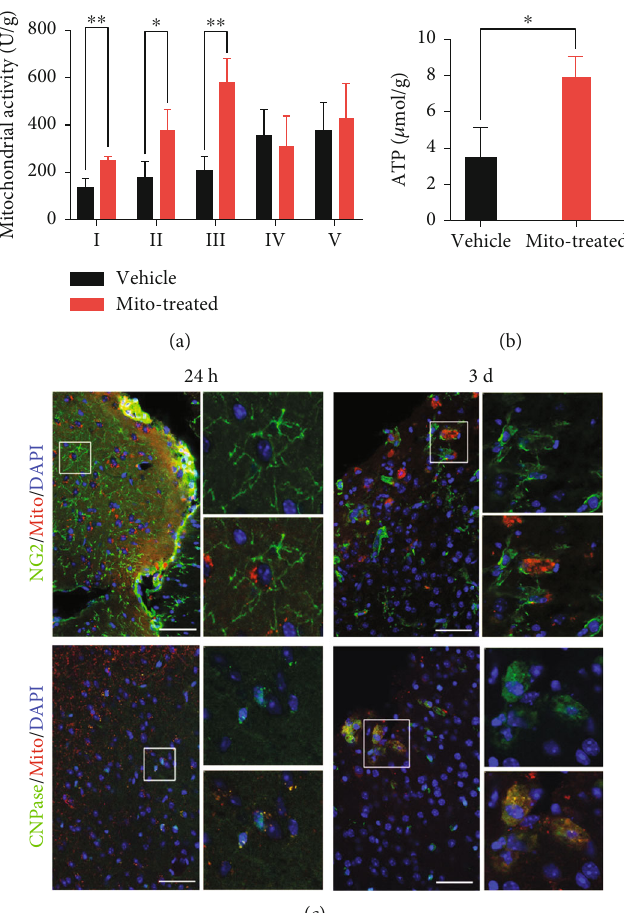
Figure 1: Restoration of mitochondrial function in ischemic cortex by exogenous mitochondria. (a) Mitochondrial complex activity in control and mitochondria-treated cortex. (b) ATP levels in control and mitochondria-treated cortex. (c) Combination of NG2 and CNPase staining with Mito-Tracker (Mito) labeling in ischemic cortex at 24 h and 3d posttransplantation. Images in the frames were magni fi ed. Notice the internalized mitochondria by NG2- and CNPase-positive cells. Notice the increase of mitochondrial complex activity and ATP level in mitochondria-treated mice. One way ANOVA for (a). Student ’ s t test for (b). n = 5 mice per group in (a, b). N = 3 mice per group in (c). ∗ P < 0 : 05 . ∗∗ P < 0 : 01 . Bars = 50 μ m